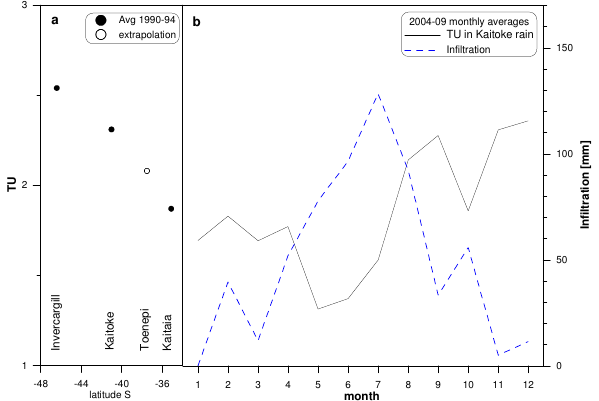
Fig. 4. (a) Average tritium concentration in rain of three reference stations (Invercargill, Kaitoke, Kaitaia) with the extrapolated value for Toenepi indicating a scaling factor of 0.9 relative to the Kaitoke reference record, and (b) monthly variation of tritium concentration and infiltration (as estimated by precipitation – potential evapotranspiration) at Toenepi. Meteorological data are from the Lincoln Ventures Ltd meteorological station in the Toenepi catchment (see Fig. 3).